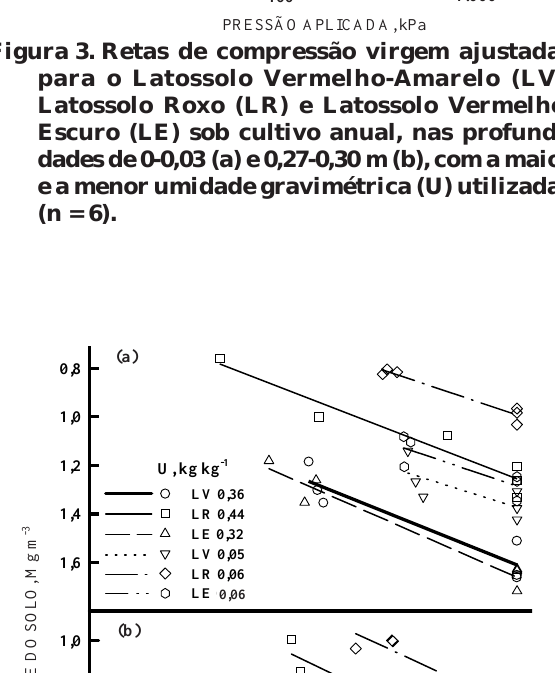
As figuras 7, 8 e 9 apresentam o índice de compressão plotado versus a umidade gravimétrica, para as condições deste estudo. Por meio destas figuras, obteve-se m = f(U), conforme sugerido por Dias Junior